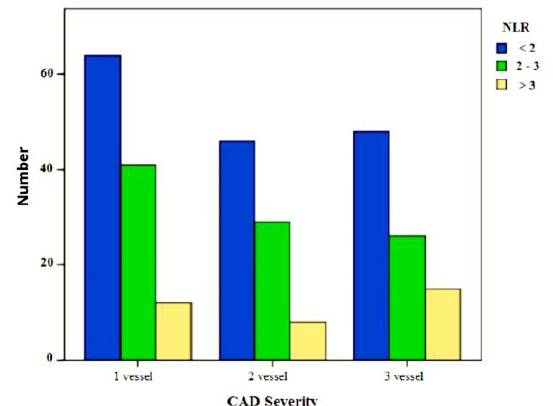
Figure 3. Number of patients in different NLR groups according to severity of coronary disease associated with more severe